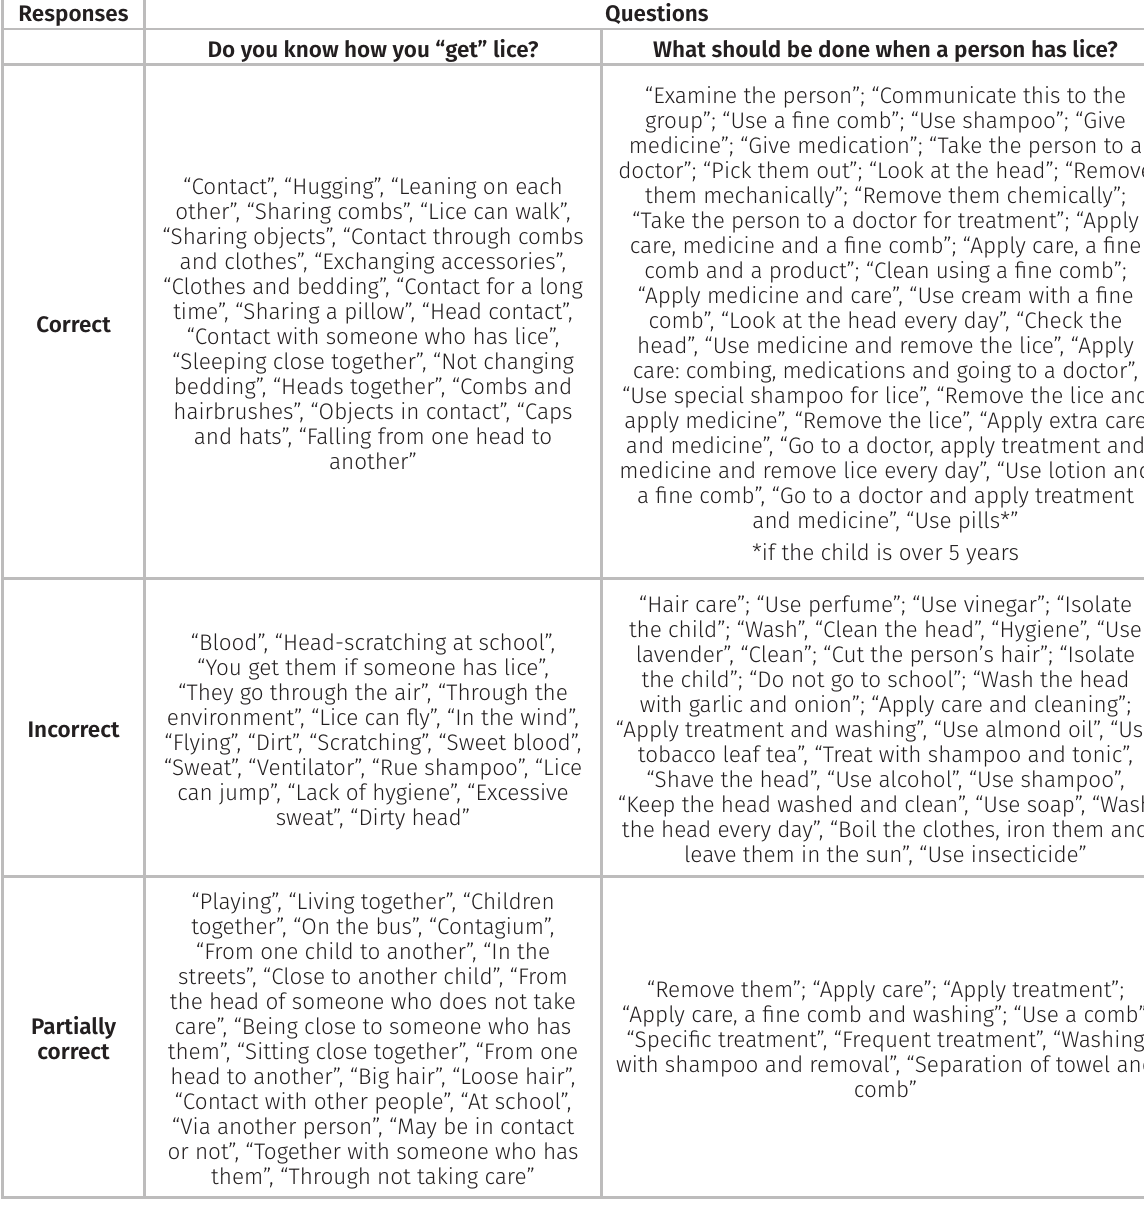
Table II. Classification of the responses to the open questions in the questionnaire applied to the parents and guardians of the schoolchildren in years 1-5, in Niterói, RJ,